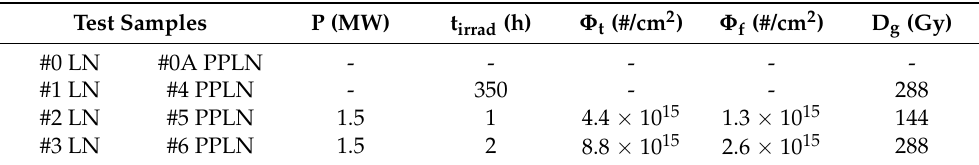
Table 1. Neutron/gamma irradiation conditions of the lithium niobate test samples. Test